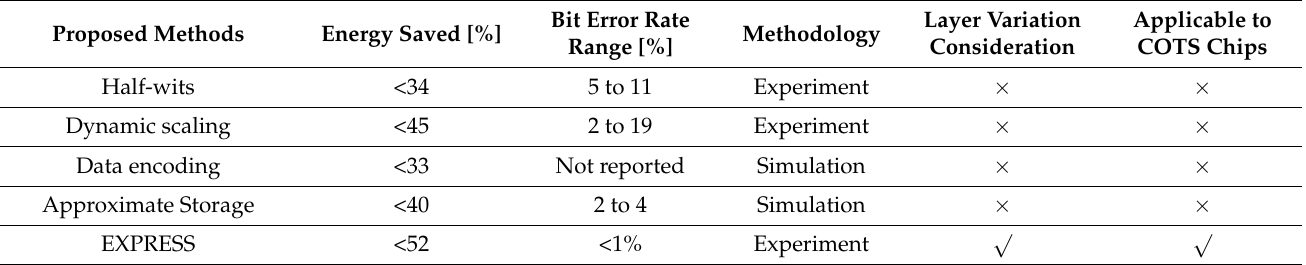
Table 1. Comparison of EXPRESS method with existing